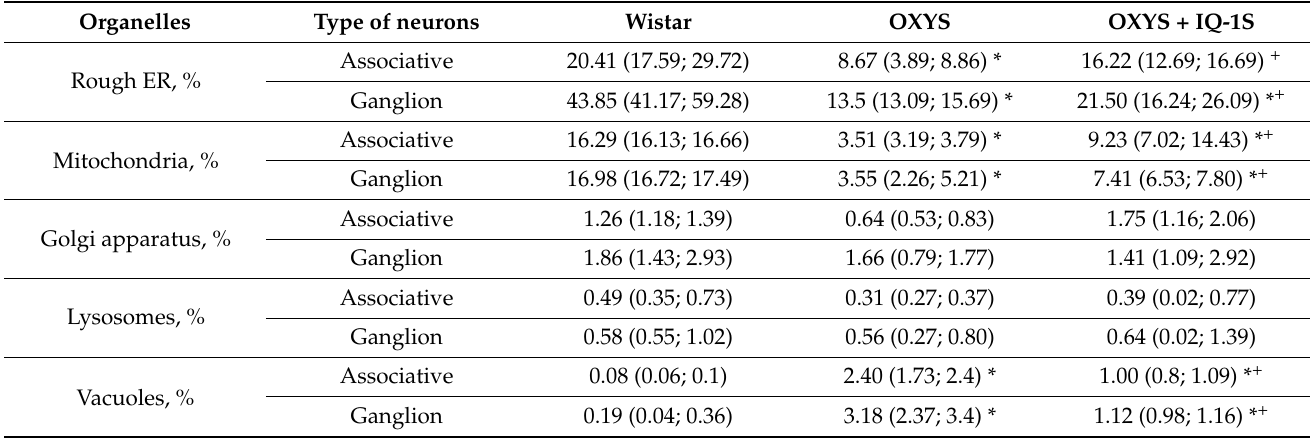
Table 2. Effects of IQ-1S on the specific areas of organelles in the cytoplasm of associative and ganglion neurons (according to electron